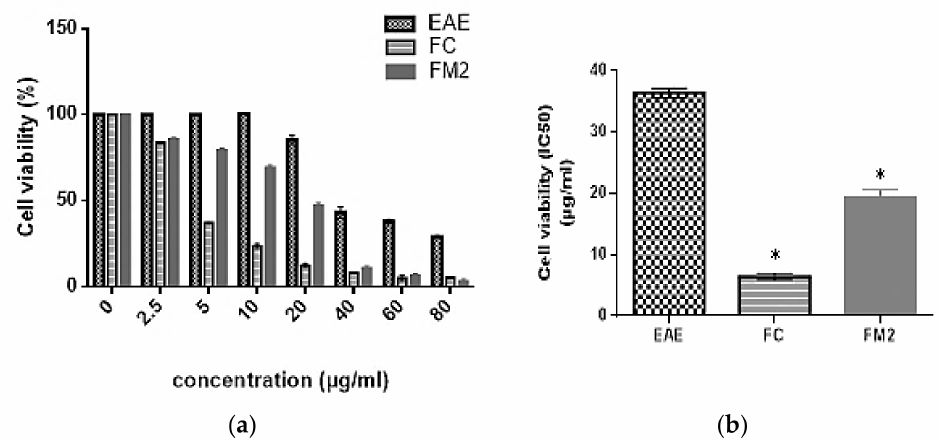
Figure 8. Cytotoxic effect of ethyl acetate extract (EAE), quercetin-3- O -rhamnoside (FC), and myricetin-3- O -rhamnoside (FM2) on B16 cells ( a ) at different concentrations and ( b ) their IC 50 values. (Bars, ± SD ( n = 3)), * significant p < 0.0001 compared to